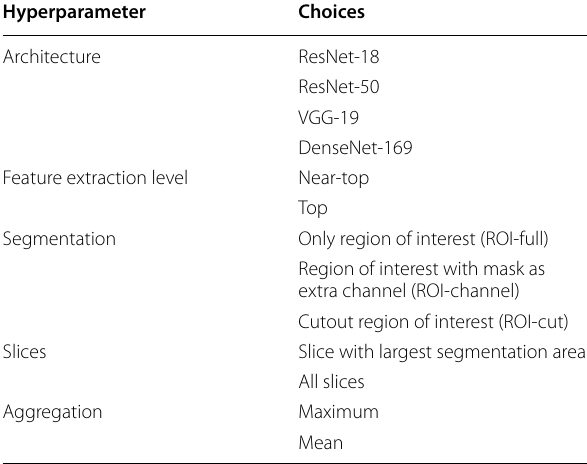
Table 2 Hyperparameters for the extraction of deep features